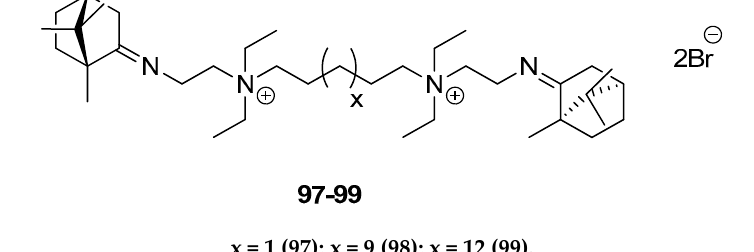
x = 1 (97); x = 9 (98); x = 12 (99). Figure 25. Quaternary ammonium (+)-camphor derivatives.